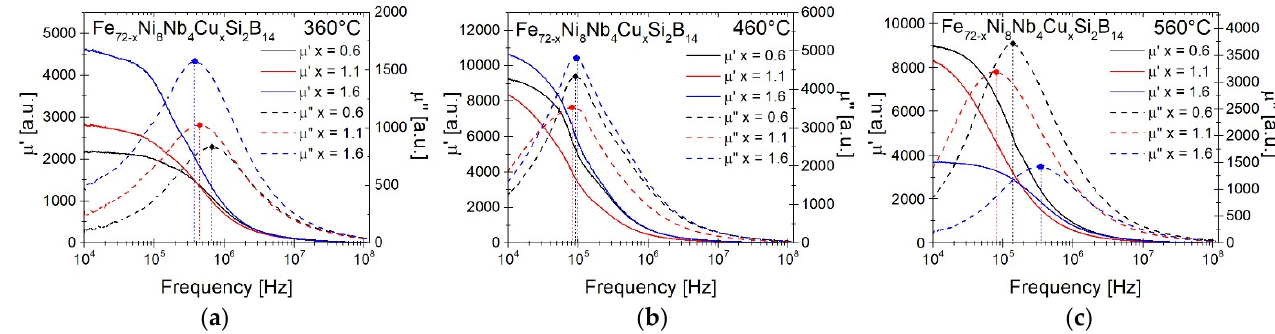
Figure 6. Magnetic permeability µ ′ and magnetic loss permeability µ ″ dependence as a function of frequency for samples annealed at 360 °C ( a ), 460 °C ( b ), and 560 °C ( c ). Table 3. Magnetic permeability µ ′ at 10 4 Hz and cut-off frequency for annealed toroidal cores at characteristic temperatures. Alloy